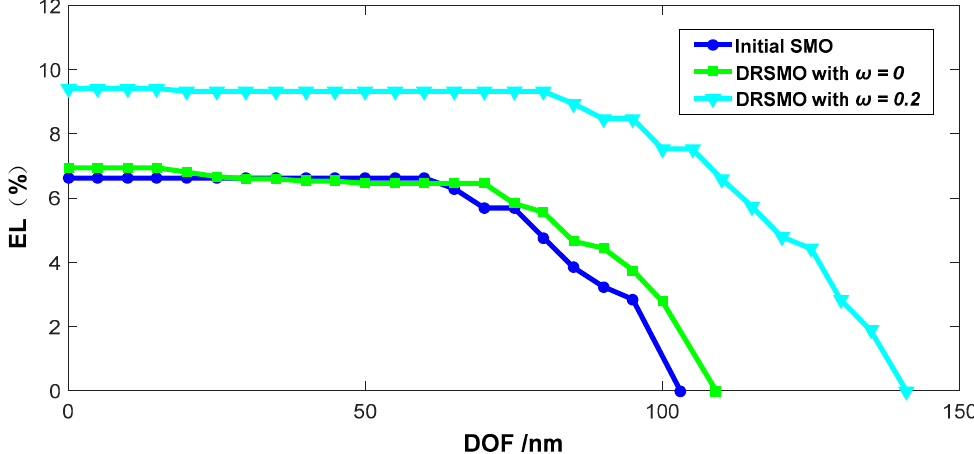
Figure 7. PWs of target 2 for the initial SMO (blue curve) and the DRSMO with the weight factors ω = 0 (green curve) and ω = 0.2 (azury curve), respectively. Optimizations were proceeded by the MBGD algorithm. Table 3. The target 2 optimized values of S β , DOF (nm) corresponding to ELs equal to 5% and 8% for the conventional SMO, and DRSMO with ω = 0, ω = 0.1, ω = 0.2, and ω = 0.3, respectively.